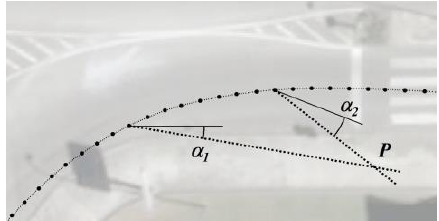
Figure 6. Planar intersection of lines defined for an object observed on two different frames.